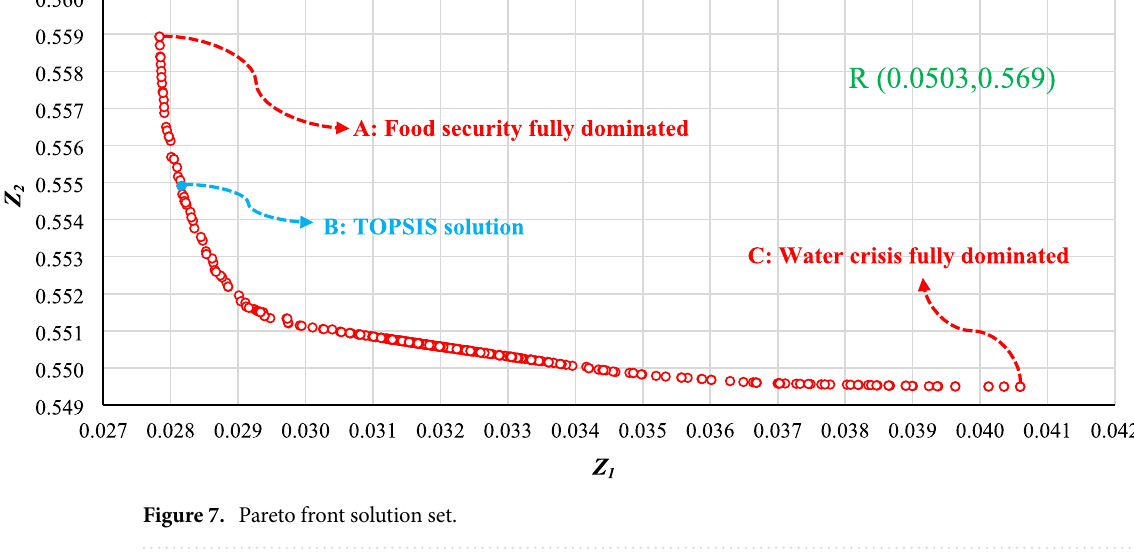
Figure 7. Pareto front solution